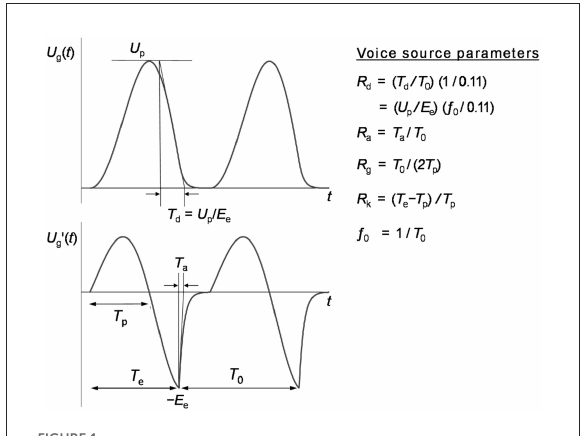
FIGURE1 The LF-model extended to include the R d parameter (adapted from Fant,